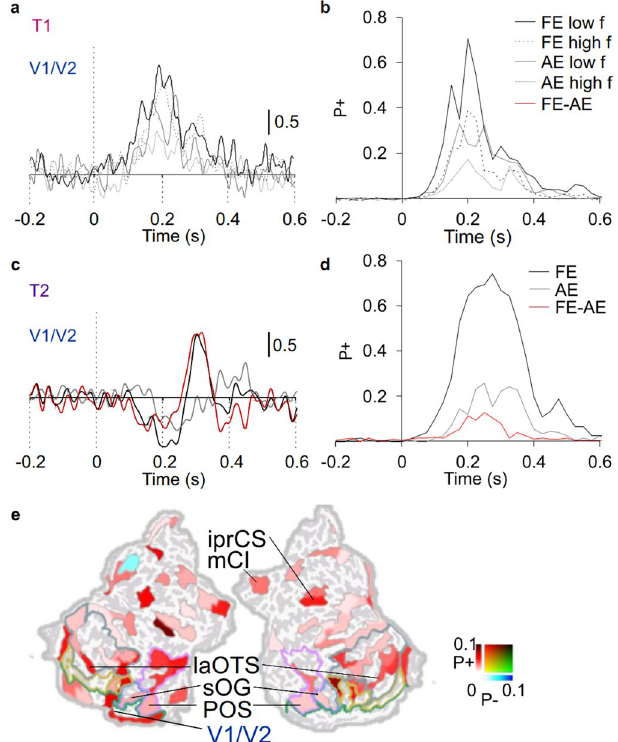
Figure 2. ERs are reduced for AE in T2. ( a ) ER waveforms in V1/V2 for T1. ( b ) The fraction of parcels ( P +) showing significant ER compared to the baseline. Black line denotes fraction of parcels for FE and grey line that for AE ( t -test, threshold p < 0.05, FDR corrected). ( c , d ) Same as in ( a , b ) for T2. Black line denotes the fraction of parcels for FE, grey for AE. The red line indicates fraction of parcels where the difference in the strengths of ERs between FE and AE ER was significantly different ( t -test, threshold p < 0.05, FRD corrected, see “Methods”). ( e ) Cortical parcels in which ERs were stronger for stimuli presented to FE than AE in T2. Colours indicate the fraction of parcels with positive (red) or negative (blue) difference over 0.1–0.4 s. The coloured lines define boundaries for functional visual regions of interest (blue: lateral occipital, green: V1/V2, grey: ventral, pink: dorsal, yellow: V4–V8 49–51